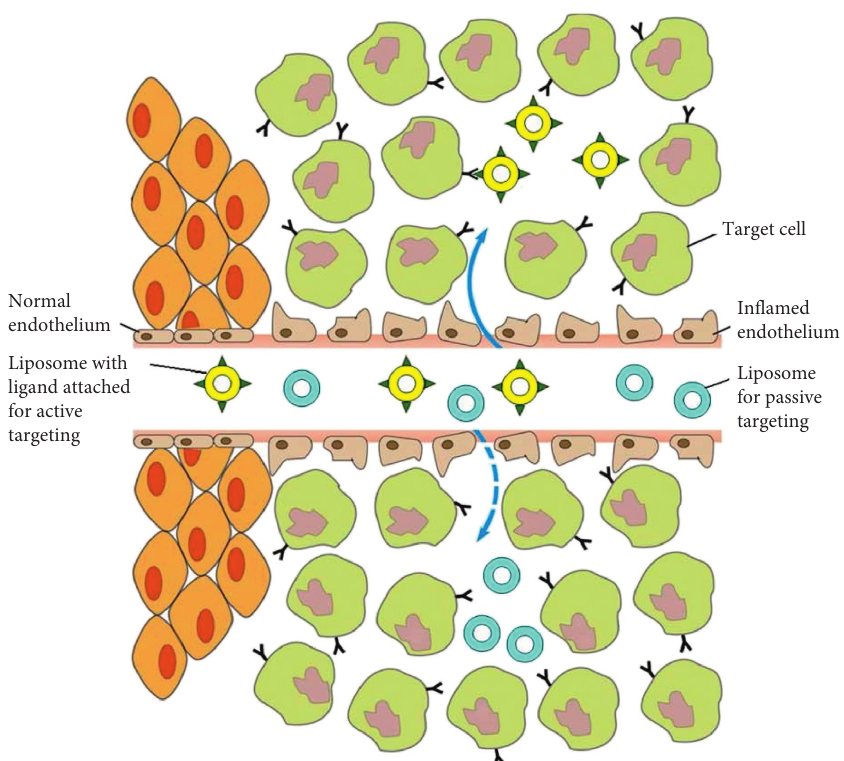
Figure 5: Diagram demonstrating the extravasation of liposomes into the interstitial fluid via cell gaps. Drug release occurs once ligands conjugated to liposomes bind to specific target cell receptors via active targeting. Local high-concentration drug release mediates passive targeting